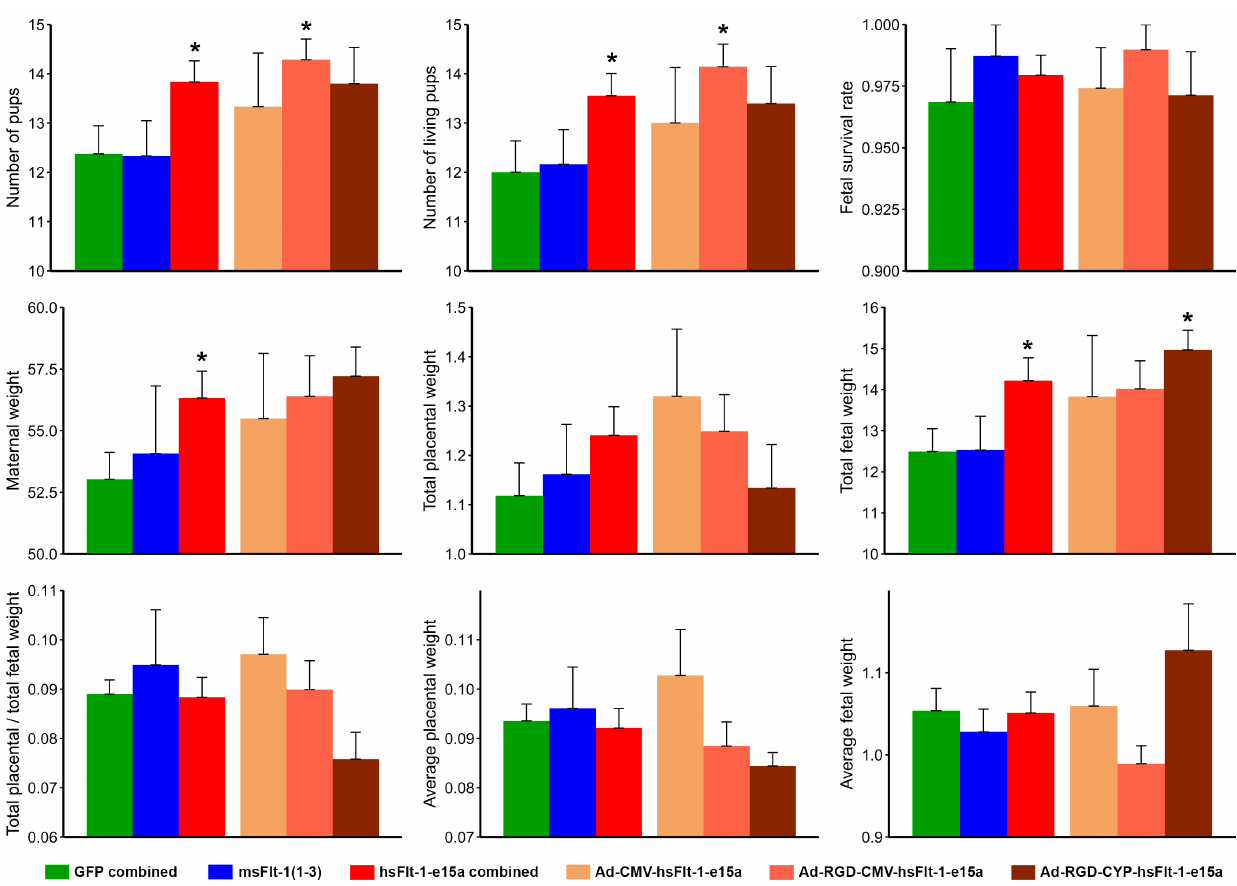
Figure 9. Litter sizes, maternal, placental and fetal weights, and placental/fetal weight ratios. Controls (n=17) and msFlt-1(1-3)-treated mice (n=6) had a litter size consistent with the strain average published by the vendor (n=11.5). The number of pups (13.8 6 0.4, p=0.046) and living pups (13.6 6 0.45, p=0.05) were higher in hsFlt-1-e15a-treated mice (n=18) than in controls. The total weight of living pups (14.2 6 0.56 g, p=0.04) and maternal weights (56.3 6 1.1 g, p=0.04) were also higher in hsFlt-1-e15a-treated mice than in controls. Truncated msFlt-1(1-3)-treated mice did not differ in any parameters from the controls. Among hsFlt-1-e15a-treated mice, the total weights of living pups was higher in the Ad-RGD-CYP- hsFlt-1-e15a treated mice than in controls (15 6 0.48 g, p=0.043). The number of pups (14.3 6 0.42, p=0.047) and the number of living pups (14.1 6 0.46, p=0.039) was higher in the Ad-RGD-CMV-hsFlt-1-e15a treated mice than in controls. Stars denote statistical significance.